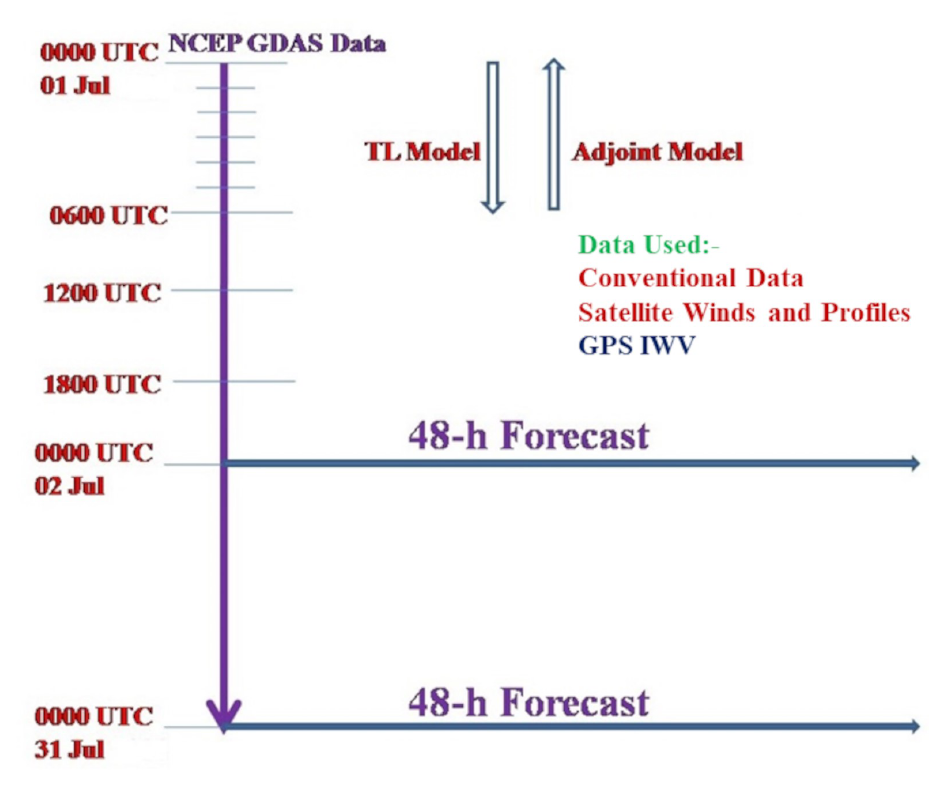
Figure 5. Schematic diagram depicting the assimilation of GPS-IWV data. Conventional Data as well as Satellite winds are assimilated 6-hourly for the control run (CNT) and GPS-IWV is added for the other experimental run).